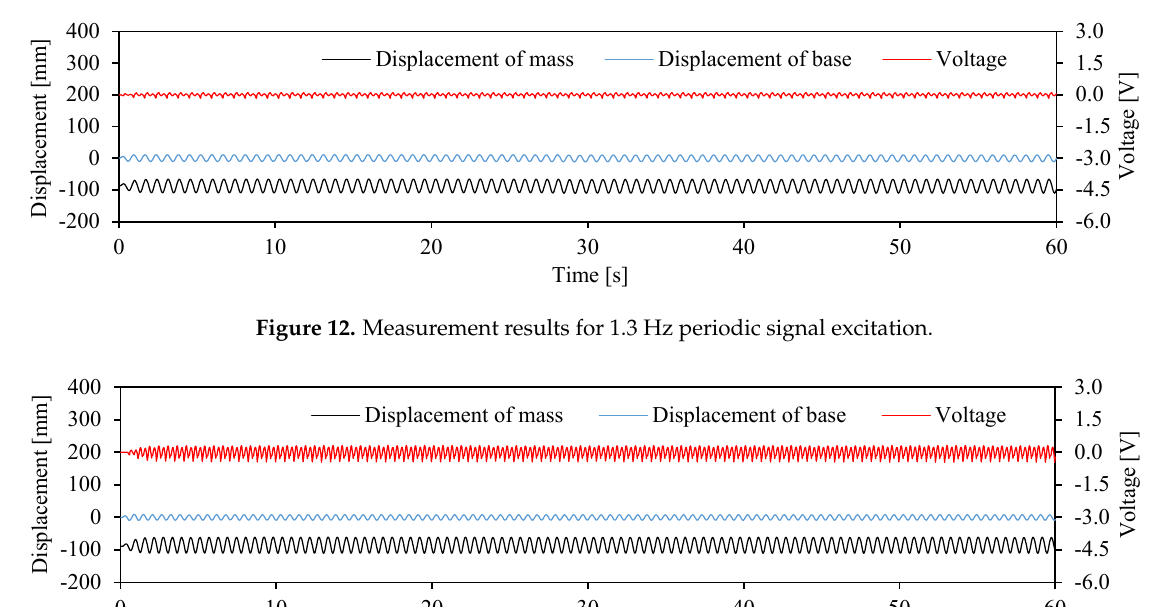
mass block was less intense than that at the excitation frequency was 1.6 Hz. The standard